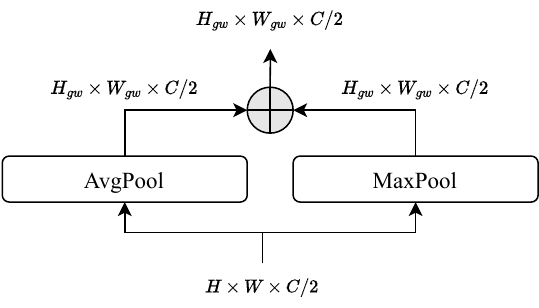
Figure 4. Patch-sampling to generate global windows. Patch-sampling consists of max- and average- pooling, which are added together at the